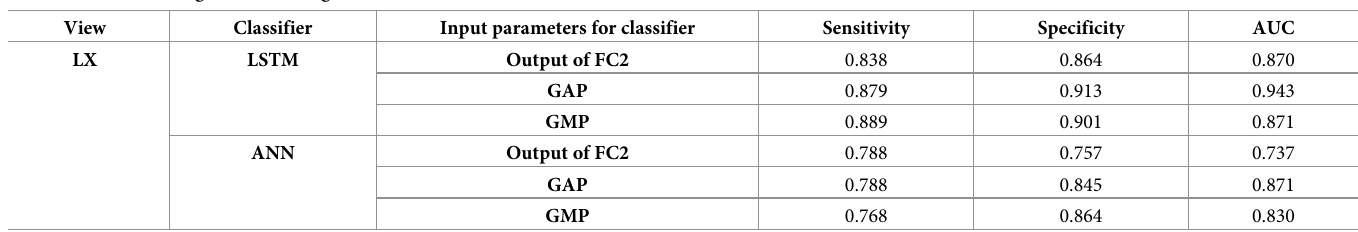
Table 7. Results of long-axis view images.